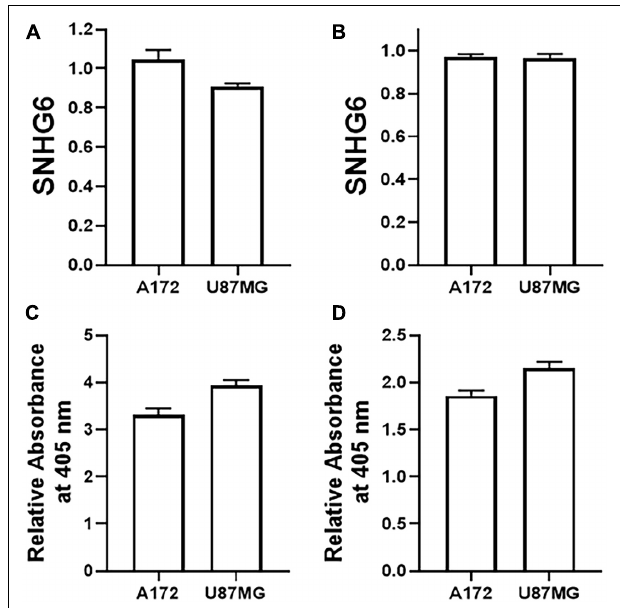
FIGURE 4 | Effect of Notch and Sox2 silencing on SNHG6. Levels of SNHG6 were evaluated in two glioma cell lines, as indicated, by qRT-PCR after silencing of (A) Notch1 and (B) Sox2. GAPDH was evaluated as internal control. The relative values are plotted, which are fold-changes compared to the respective cells transfected with non-specific siRNAs. Induction of apoptosis, upon transfection of siRNA against (C) Notch1 and (D) Sox2, in indicated cell lines, was evaluated using the apoptosis kit described in Methods. The relative OD values are plotted, which are fold-changes compared to the respective cells transfected with non-specific